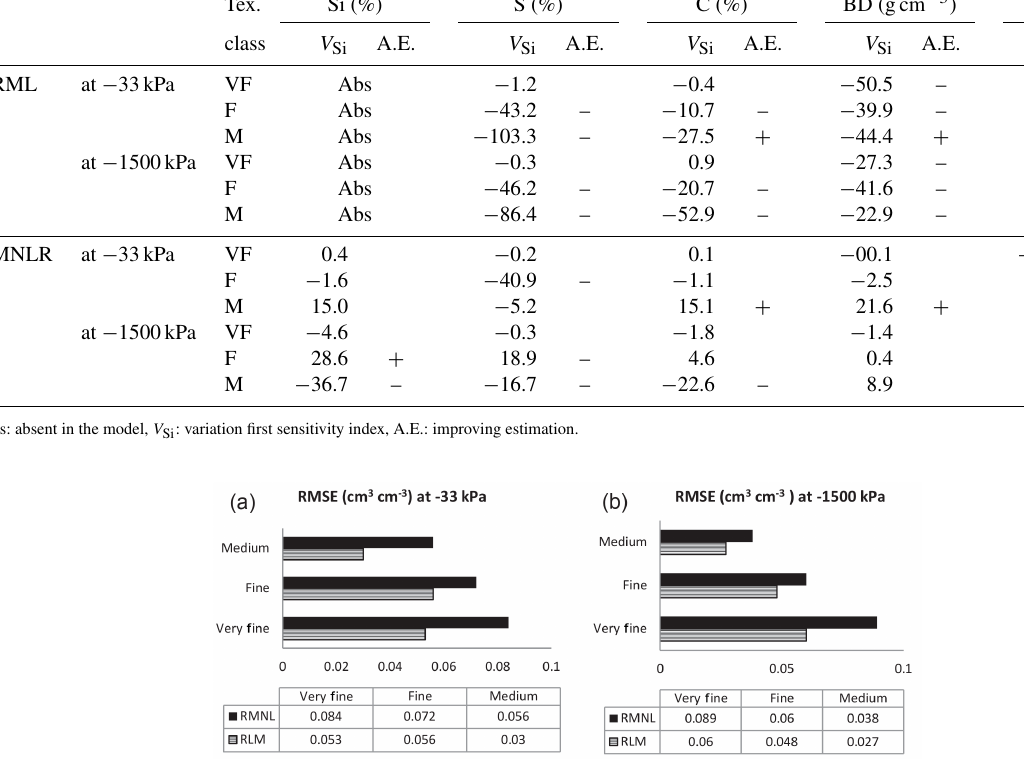
Figure 5. Root mean square error (RMSE) values calculated for the different textural classes.